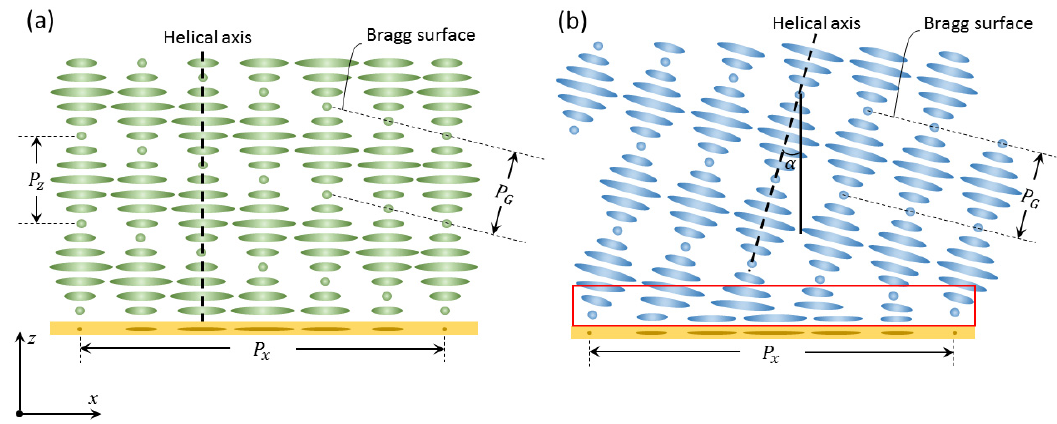
Figure 1. Di ff erent LC director configurations of PVG. ( a ) Planar-PVG with helical axis perpendicular to substrate surface. ( b ) Slanted-PVG with helical axis perpendicular to Bragg surface. The red box indicates the transitional region from planar to slanted structure.